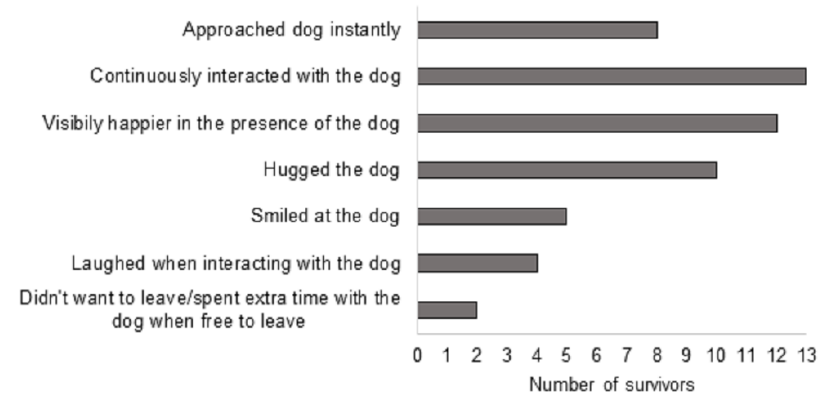
Figure 1. Observed behaviours exhibited by survivors upon initial introductions with the dog.